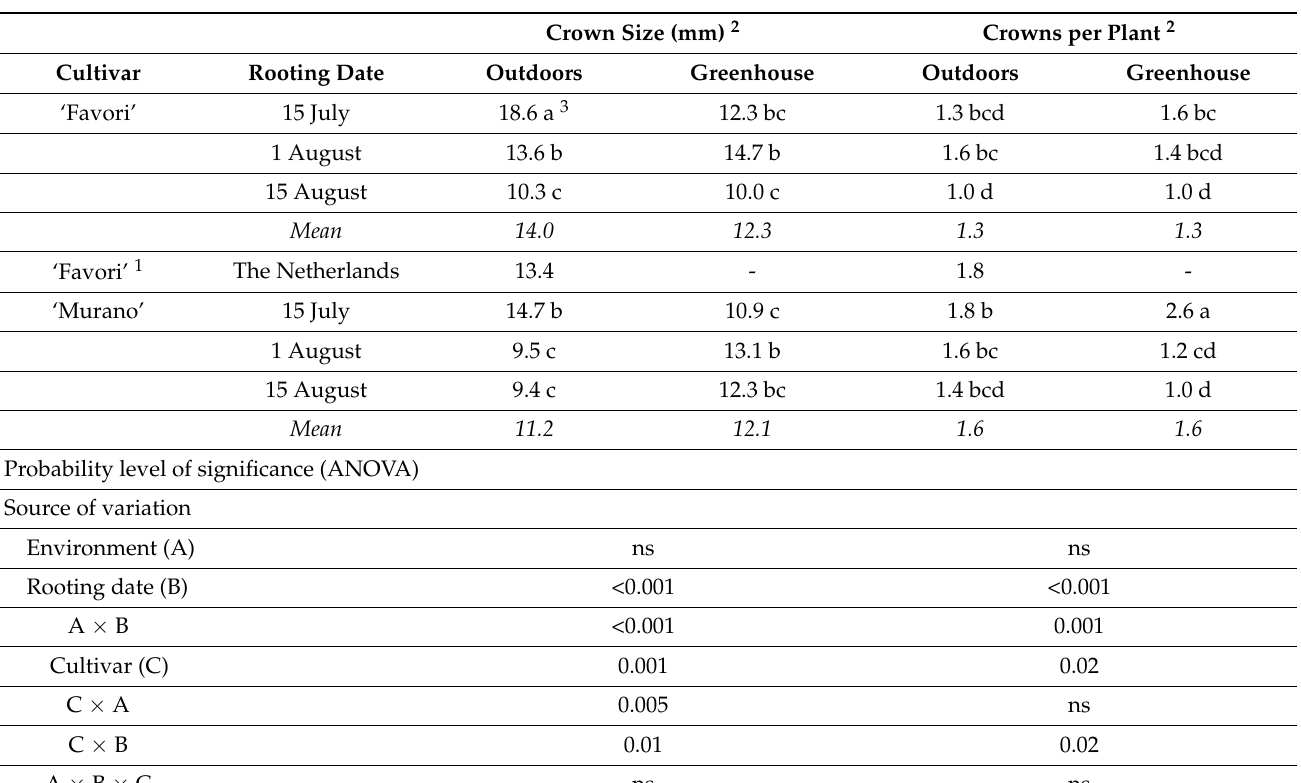
Table 1. Effects of rooting date and raising environment on crown diameter and number of crowns per plant in two everbearing strawberry cultivars. Results recorded in spring 2021 and represent the means of 10 plants in each treatment. Results for imported ‘Favori’ plants are included for